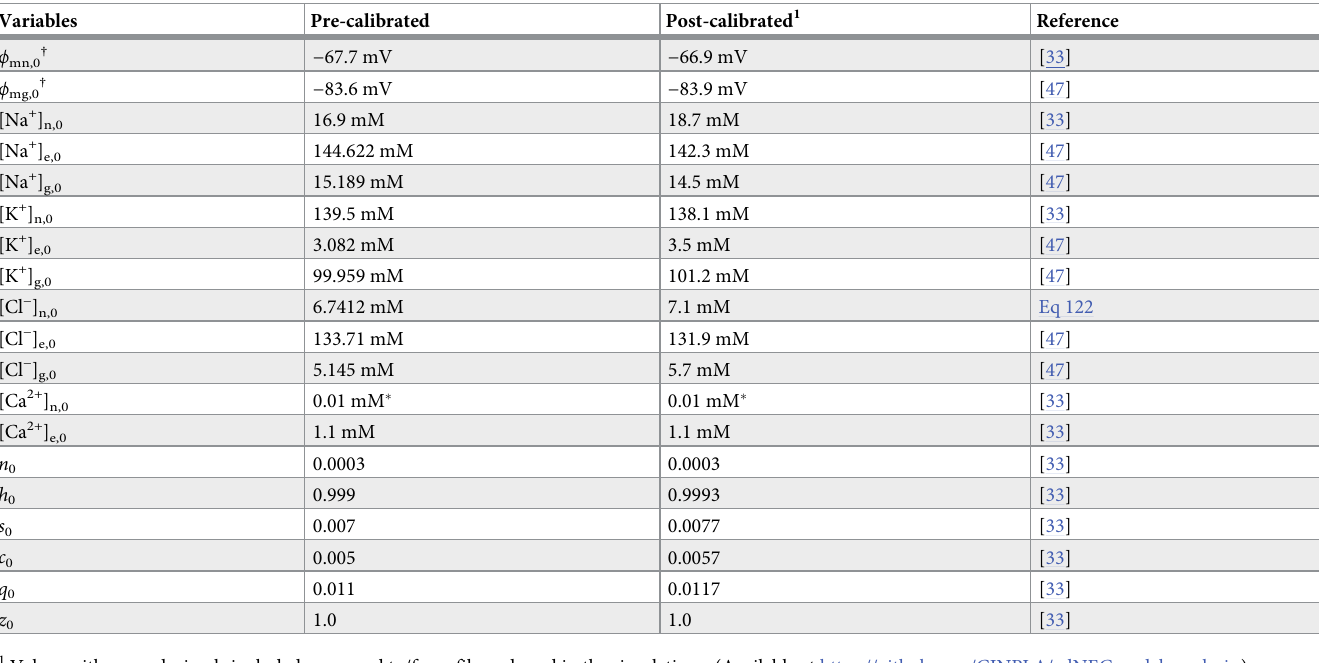
Table 5. Initial